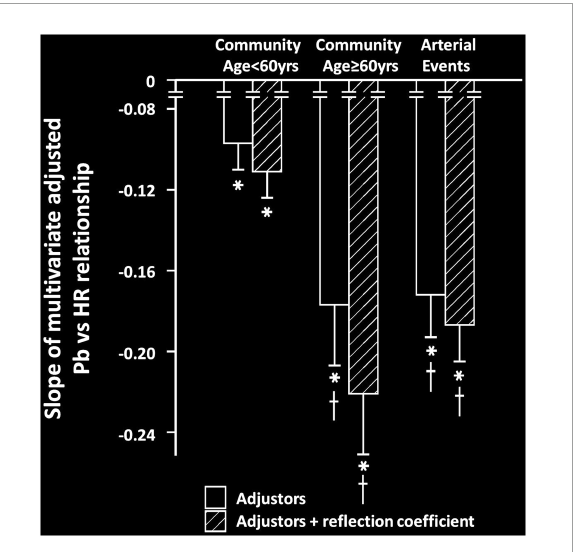
FIGURE3 Impact of adjustments for the systemic reflection coefficient on the multivariate adjusted slopes ( β -coefficient) of relationships between heart rate (HR) and backward wave pressures (Pb) in participants from a community sample either younger (community < 60 years) or older (community ≥ 60 years) than 60 years or in those with arterial events (stroke or critical limb ischemia). All data are adjusted for age, sex, MAP, BMI, regular smoking, regular alcohol, DM, and antihypertensive therapy. * p < 0.0001 for relationships. † p < 0.01 vs. slopes of relationships in community participants < 60 years. No differences between relationships were noted before and after adjustments for the systemic reflection